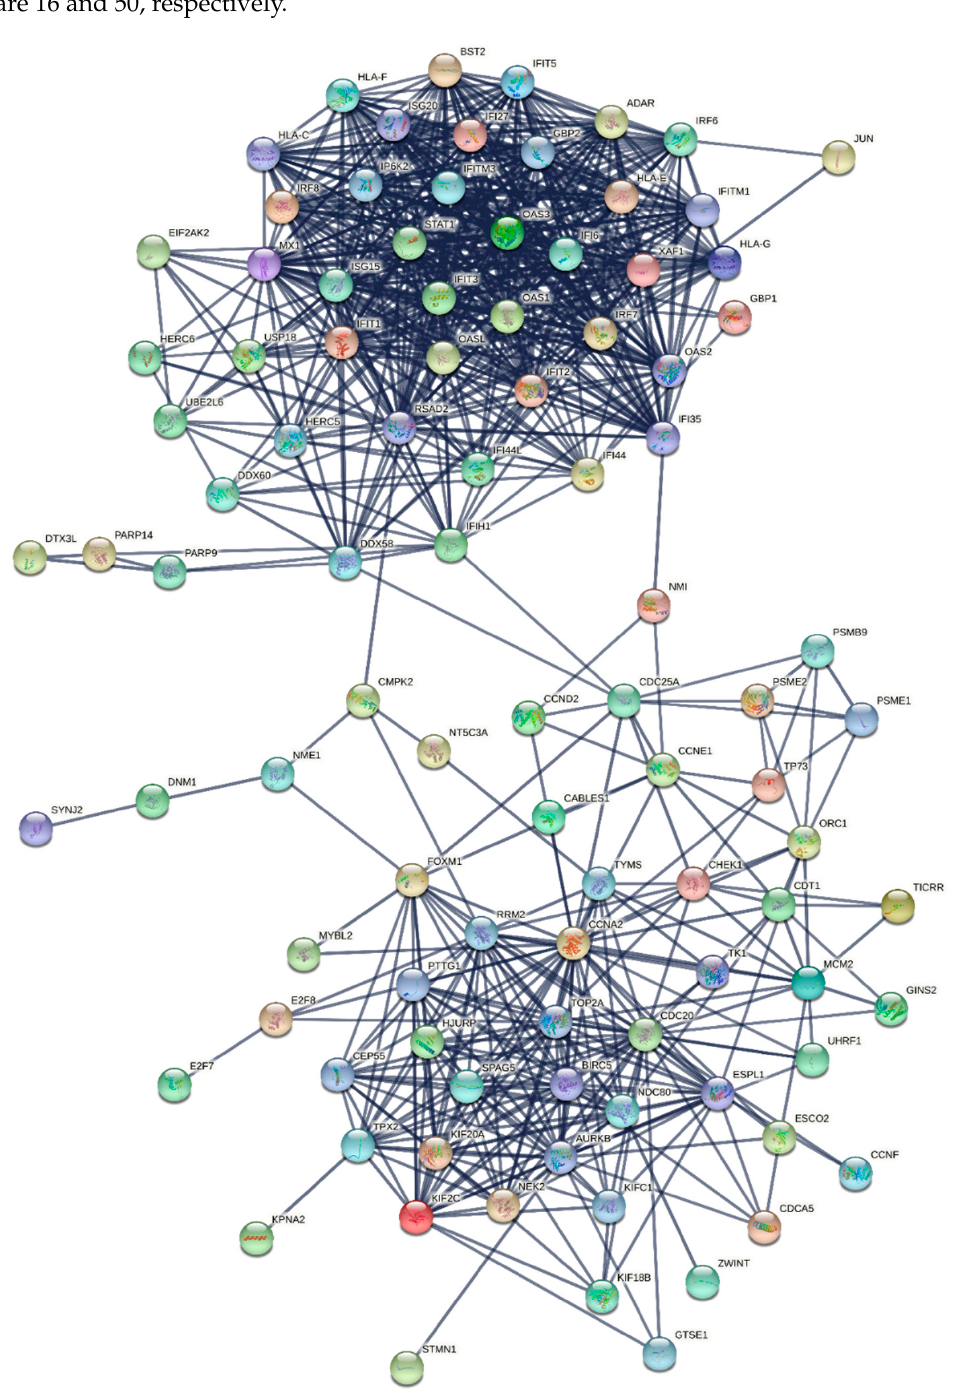
Figure 2. The largest component of the IPIN constructed from the mapping between the nodes with the significant diffusion scores and the human interactome network. The network consists of 97 nodes and 778